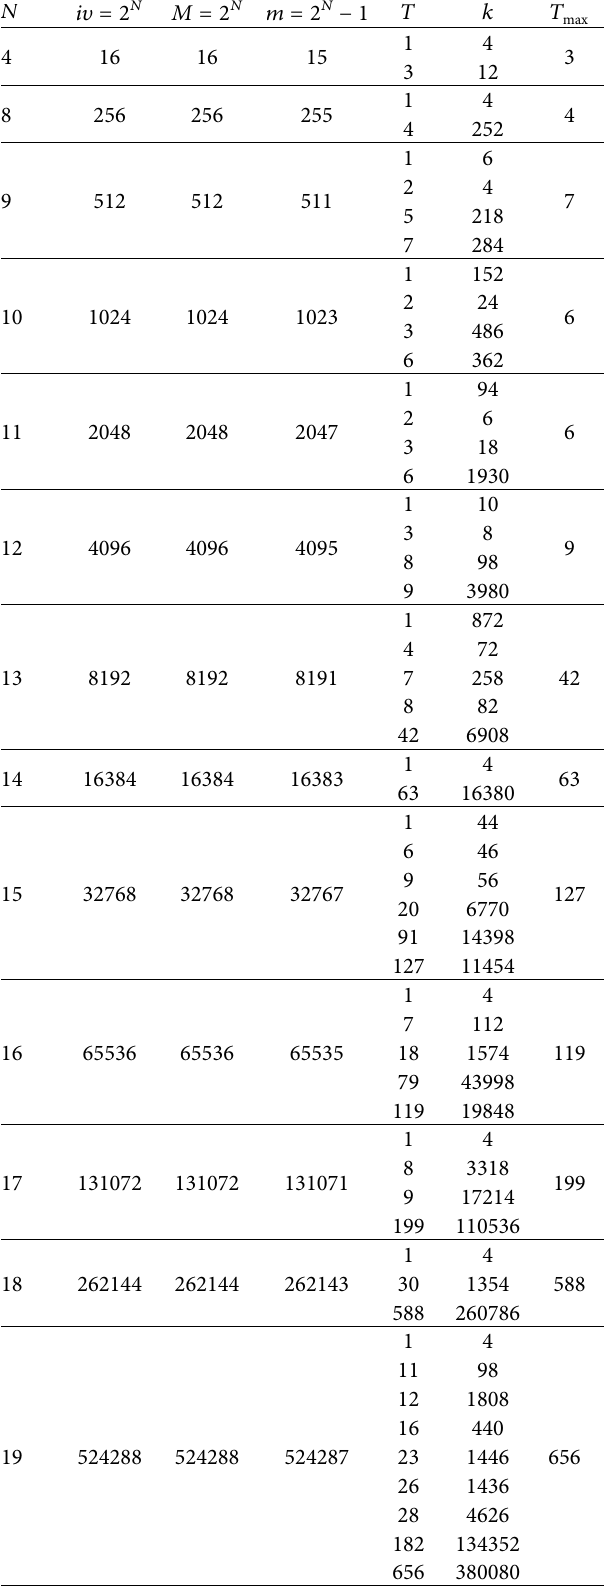
Table 4: The periodic orbits of original digitalized Logistic map with different